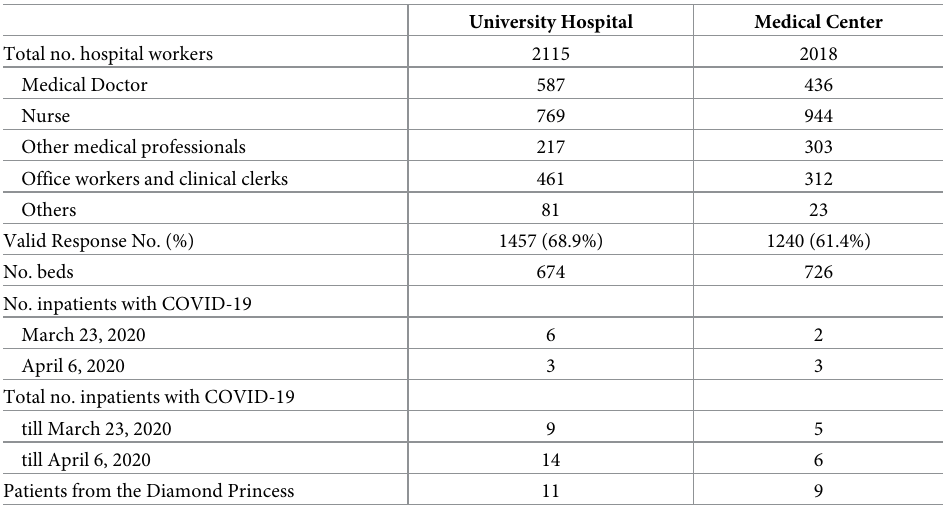
Table 1. Hospital